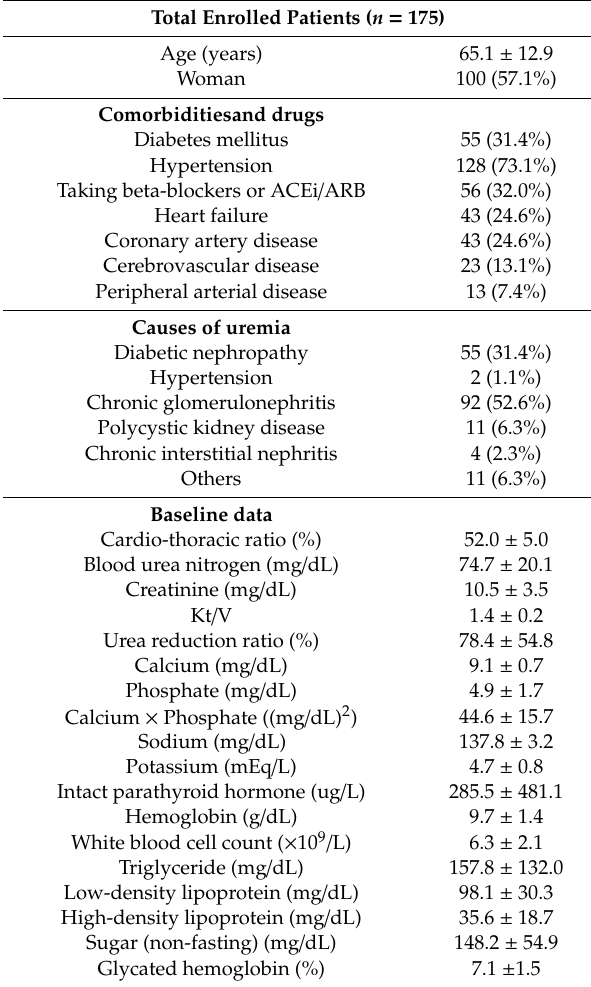
Table 1. Characteristics of enrolled